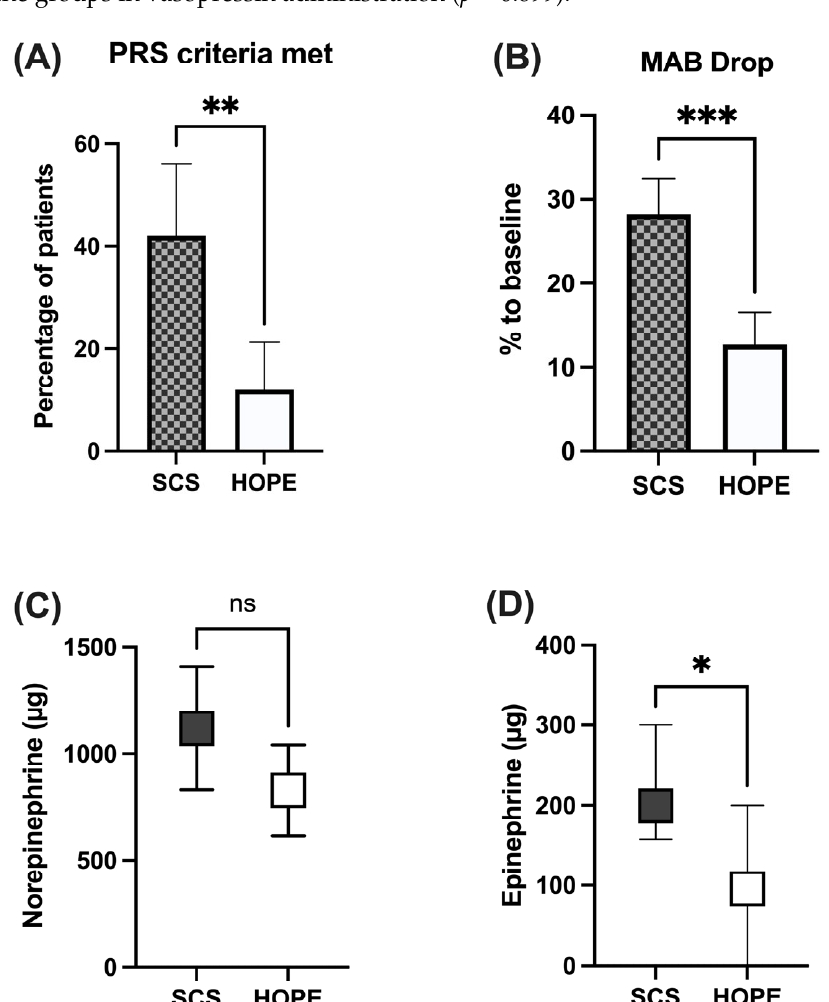
Figure 1. Graphical analysis of perioperative findings in the immediate post-reperfusion phase. ( A ) ratio of post reperfusion syndrome (PRS) occurrence in liver graft recipients (Mean ± 95% CI). HOPE preconditioning results in significantly reduced incidence of PRS as compared to SCS ( p = 0.0013); ( B ) relative decrease in mean arterial blood pressure (MAP) immediately after liver graft reperfusion